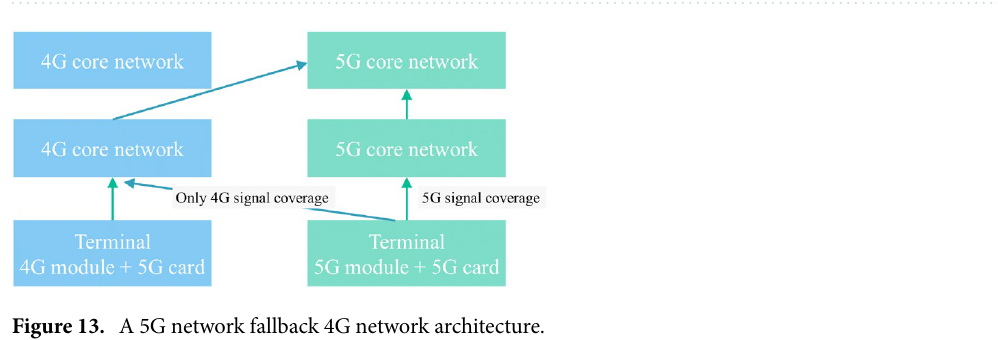
Figure 12. A comparison between the 5G uplink rate test value and the national 4G uplink rate average level in real scenarios.